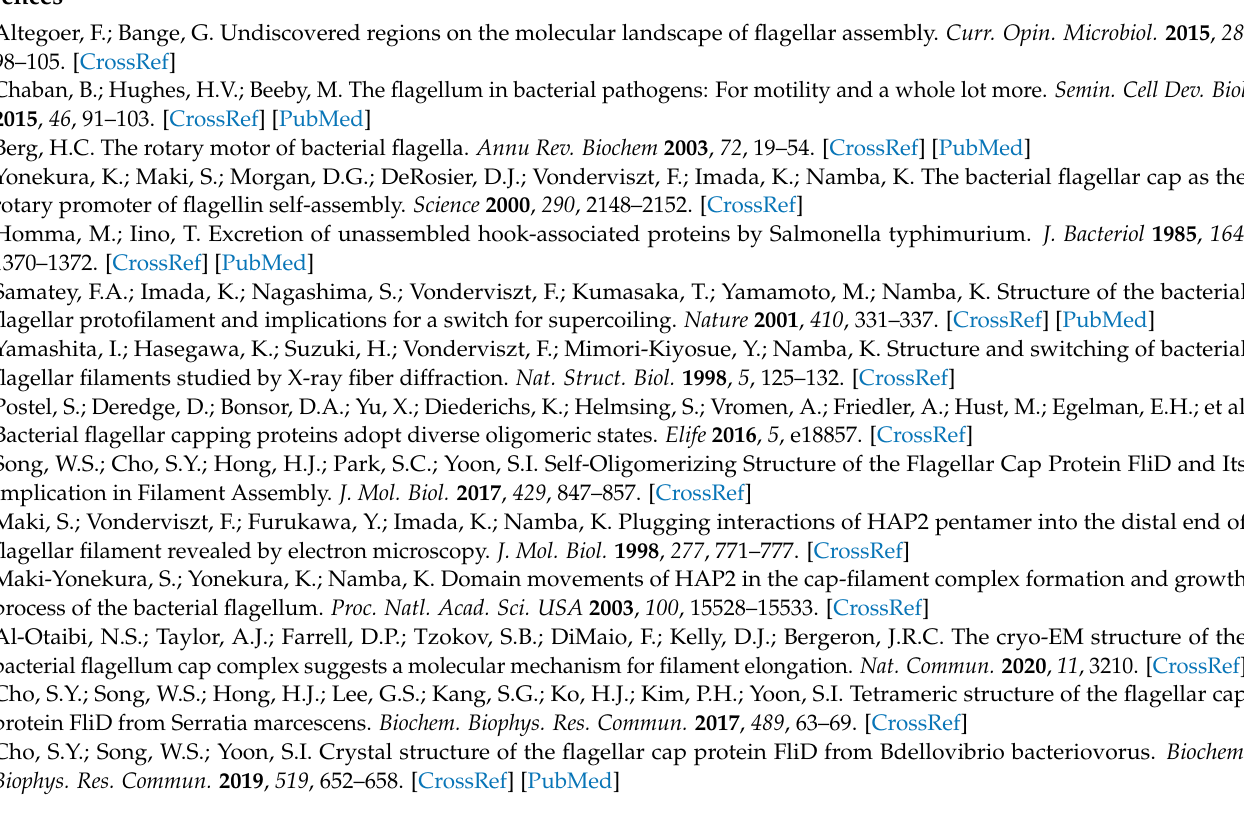
motility assays of FliD helix swaps. Representative analysis of swimming motility of FliD helix swaps. Wild type, knockout and complemented strains are shown and individually labeled. Each bacterial growth was measured as described in Materials and Methods resulting in the data shown in Figure 3; Supplemental Figure S4. Swimming motility assays of FliD truncations. Representative analysis of swimming motility of FliD truncations. Wild type, knockout and complemented strains are shown and individually labeled. Each bacterial growth was measured as described in Materials and Methods resulting in the data shown in Figure 4. Supplemental Figure S5. Swimming motility assays of FliD head/plate domain replacements. Representative analysis of swimming motility of FliD head/plate domains across a pH range between 5.8 and 8.2. Wild type, knockout and complemented strains are shown and individually labeled. Each bacterial growth was measured as described in Materials and Methods resulting in the data shown in Figure